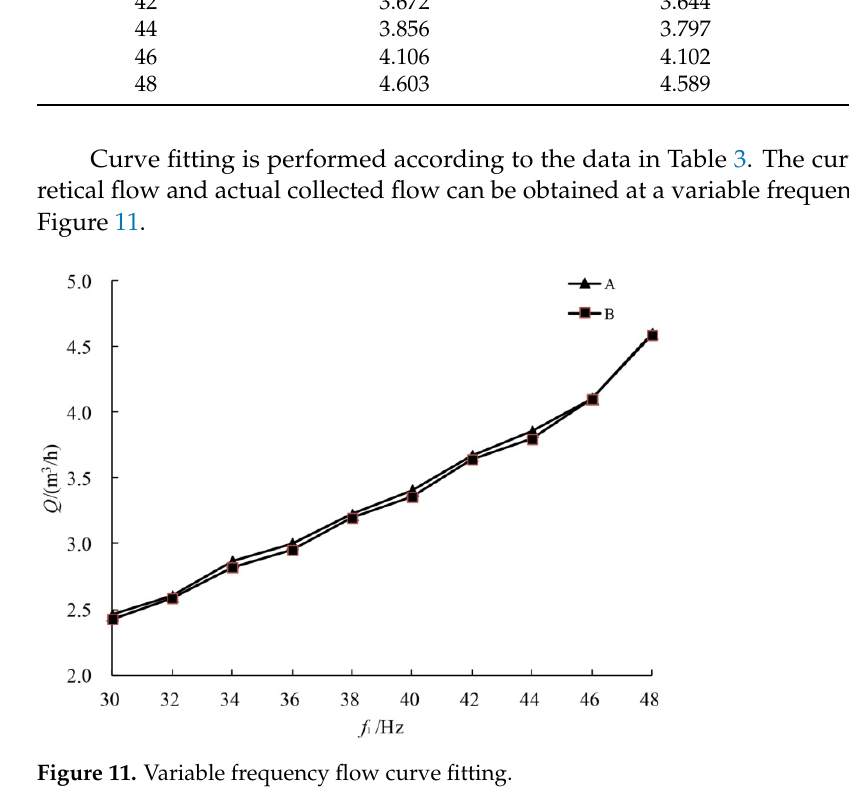
Table 3. Test results collection.